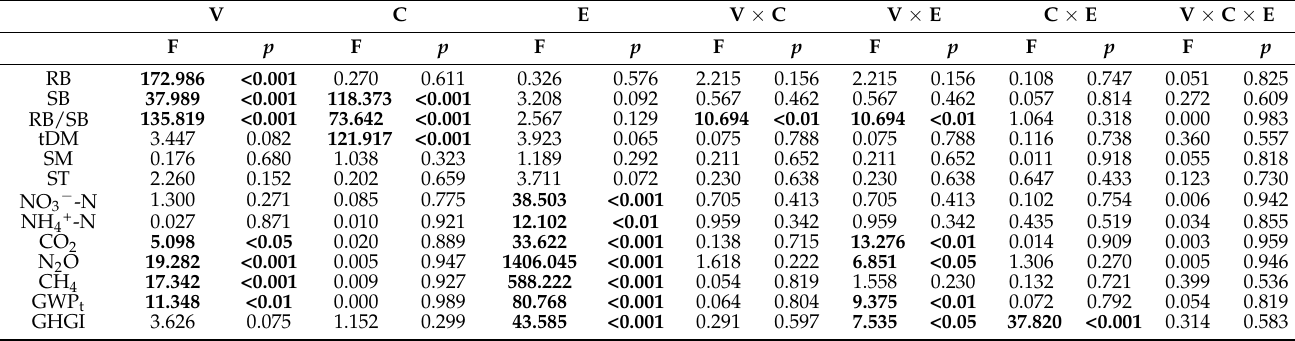
Table 1. Multivariate analysis of variance with repeated measurements for the effects of variety (V), cutting (C), excrement (E), and their interactions (V × C, V × E, C × E, and V × C × E) on root biomass (RB), shoot biomass (SB), root/shoot ratio (RB/SB), total dry matter (tDM), soil moisture (SM), soil temperature (ST), soil nitrate nitrogen (NO 3 − -N), soil ammonium nitrogen (NH 4+ -N), carbon dioxide emissions (CO 2 ), nitrous oxide emissions (N 2 O), methane emissions (CH 4 ), global warming potential (GWP), and greenhouse gas emission intensity (GHGI). In addition, the bold represent p <